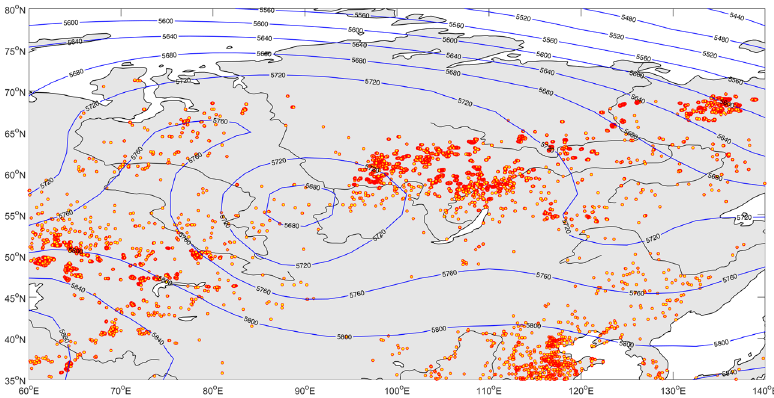
Figure 15. The total number of hotspots (FIRMS) and geopotential height at 500 hPa (12–23 July 2019) (Era-Interim).